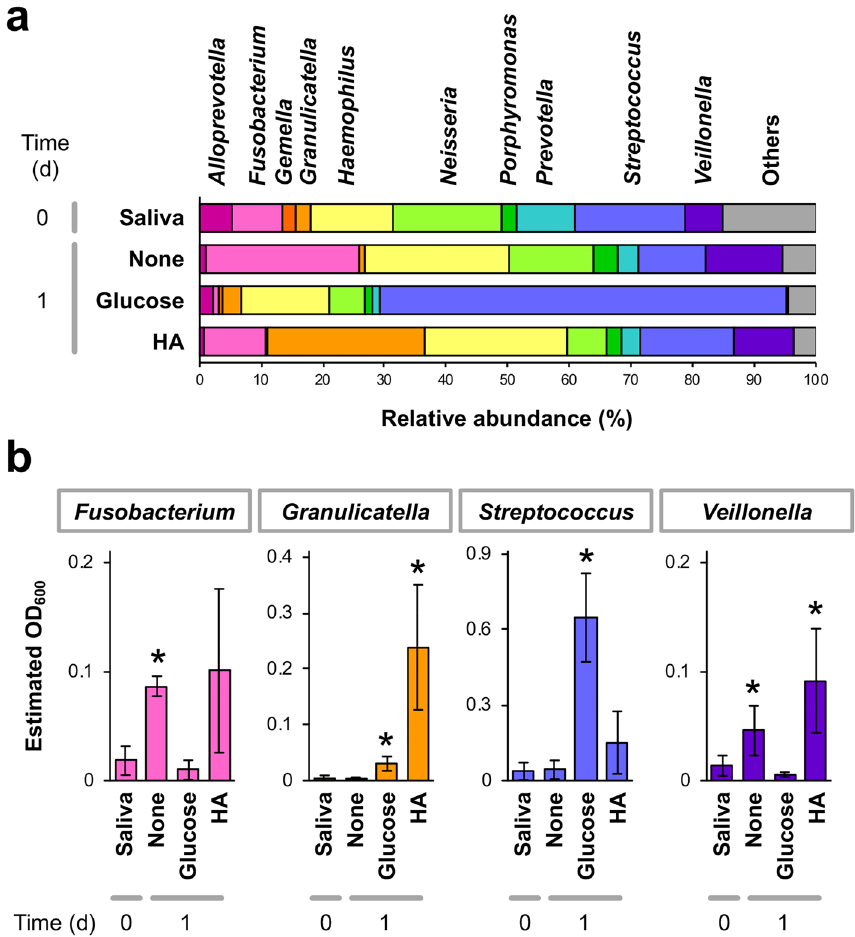
Figure 5. Metagenomic analysis of human oral microbiota cultivated under different carbon sources. Saliva samples from donors #1 to #3 were anaerobically grown in nutrient-poor medium (1/20 × GAM) or the same liquid medium but containing glucose or HA as a carbon source. ( a ) Genera frequency profiles averaged among three donors. Saliva samples before inoculation and the microbial communities after 1-day cultivation were subjected to 16S rRNA gene-based metagenomic analysis. ( b ) Estimated growth profiles of Fusobacterium , Granulicatella , Streptococcus , and Veillonella genera in the microbial communities, averaged among three donors. Growth was estimated by multiplying the occupancy and whole optical density at 600 nm (OD 600 ) value. * p < 0.05, significant growth promotion compared to the original saliva sample ( t test). HA promoted the growth of Granulicatella